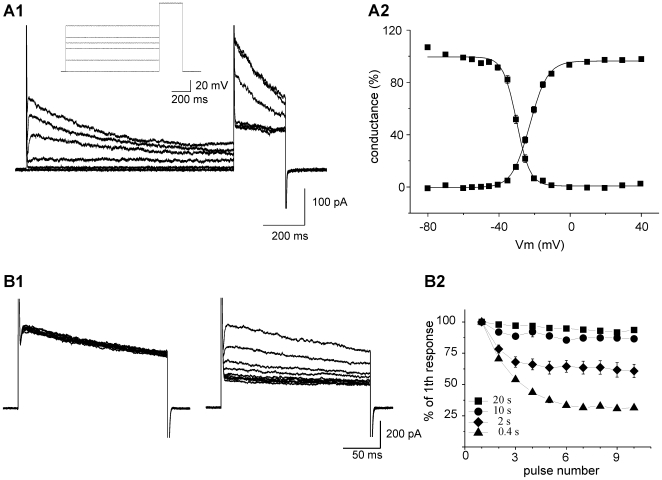
Biophysical properties of potassium channels expressed in microglial cells after status epilepticus.A1 Example of currents used to obtain activation and inactivation curves in microglia after status epilepticus. Microglia cells were held at a potential of −70 mV and stepped at different potentials for 1 s before a final step of 250 ms at +50 mV. The inset represents the voltage steps corresponding to the current traces showed in the figure. A2 Average of activation and inactivation curves (n = 13) normalized to maximal conductance. B1 Examples of currents induced in another microglial cell by 10 consecutive pulses from −70 to +30 mV with 30 s interval (left panel) or 0.4 s interval (right panel). B2 Evolution of the peak current amplitude obtained at every pulse expressed as percentage of the first response for 7 tested cells. Note that the smaller is the inter-pulse interval, the higher is the inactivation of the current.